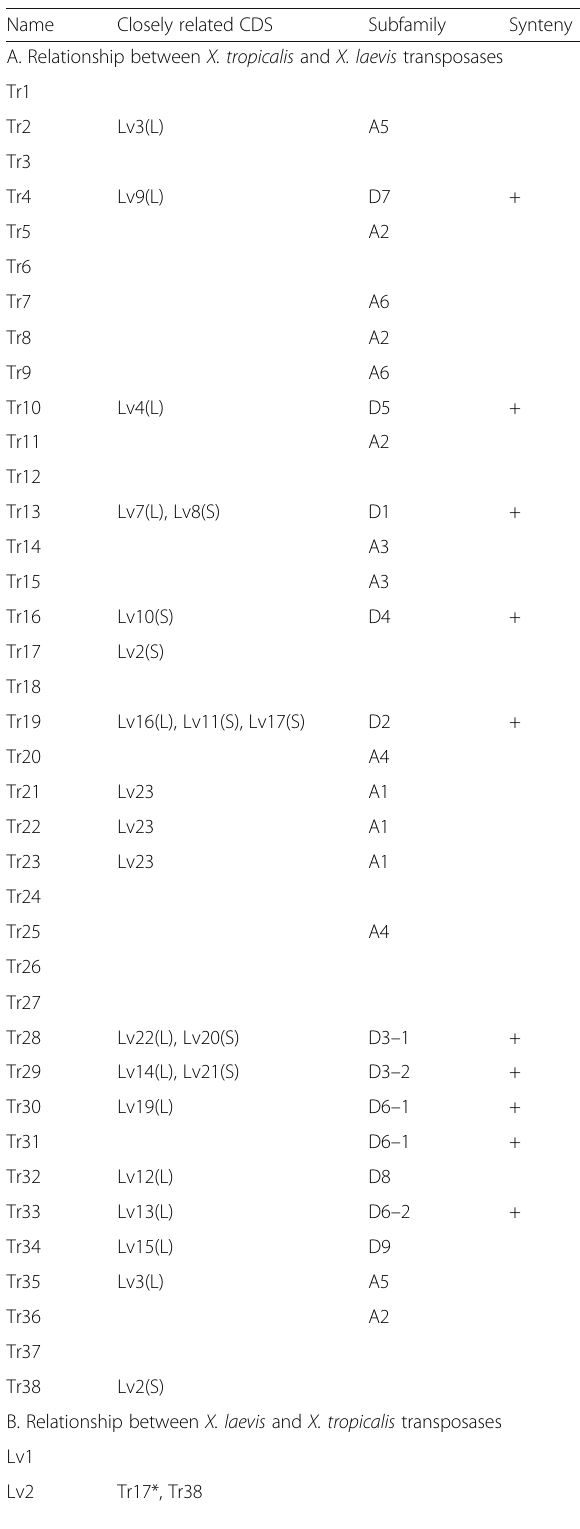
Table 3 Relationship of transposases between X. tropicalis and X. laevis